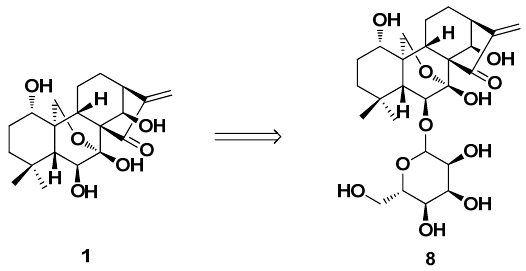
Figure 5. Synthesis of oridonin-6- O - α - D -glucopyranoside ( 8 ).